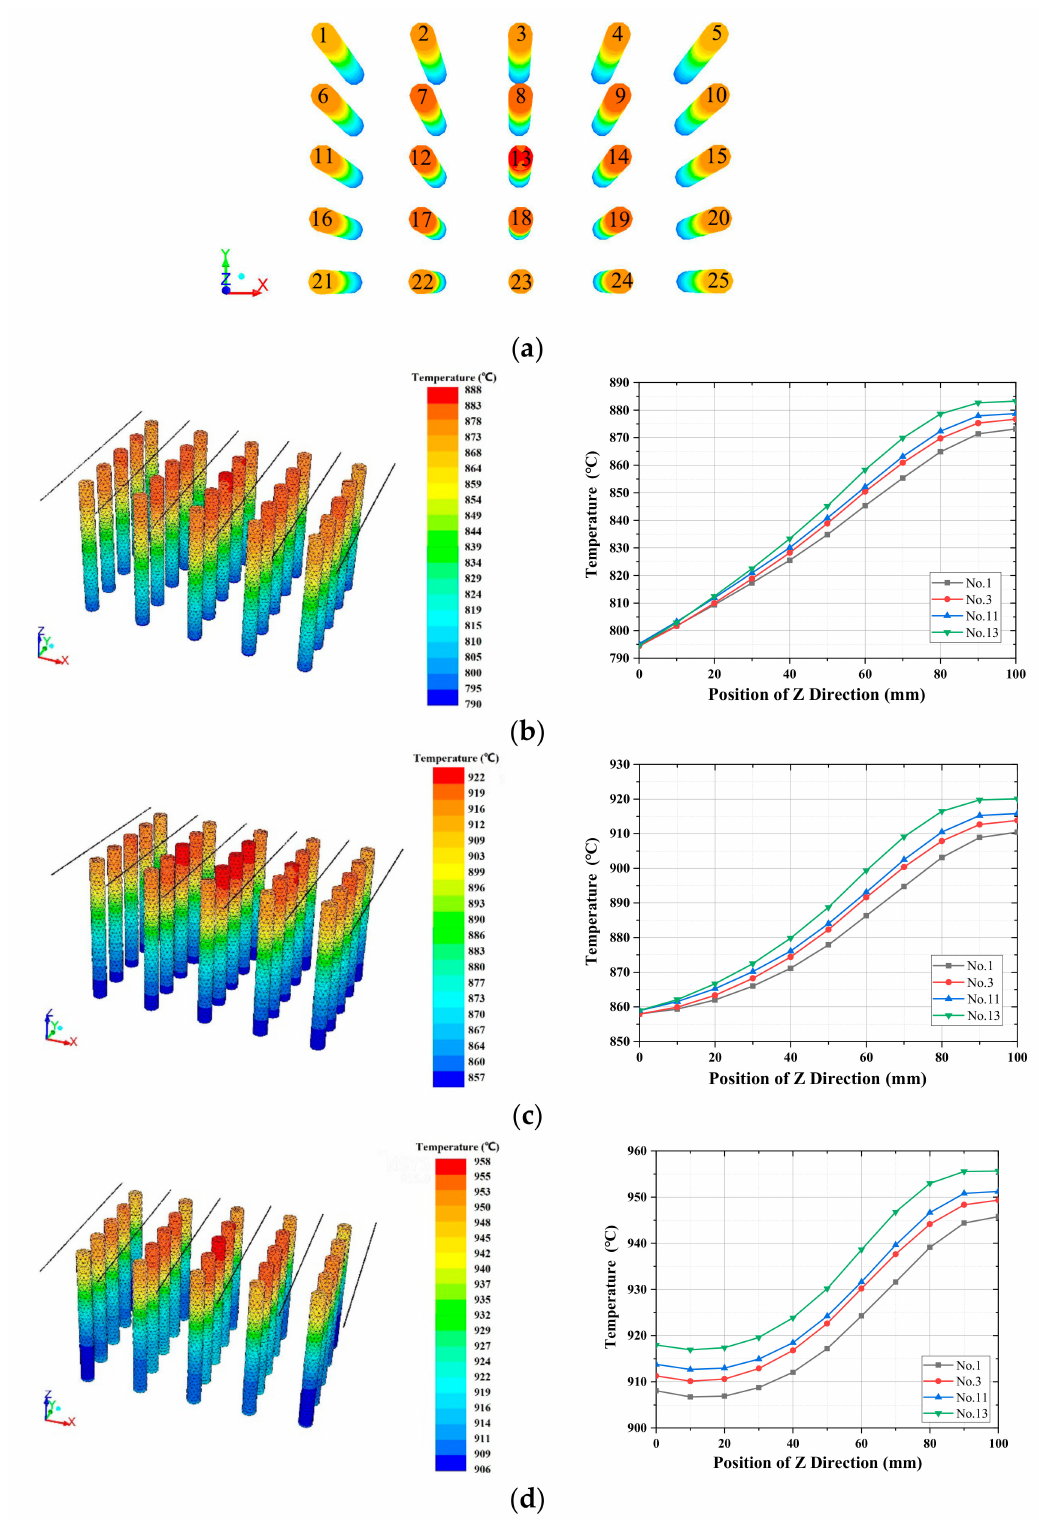
Figure 3. ( a ) The number order of milling tools; the temperature distribution of milling tools in the ( b ) copper, ( c ) graphite, and ( d ) ceramic